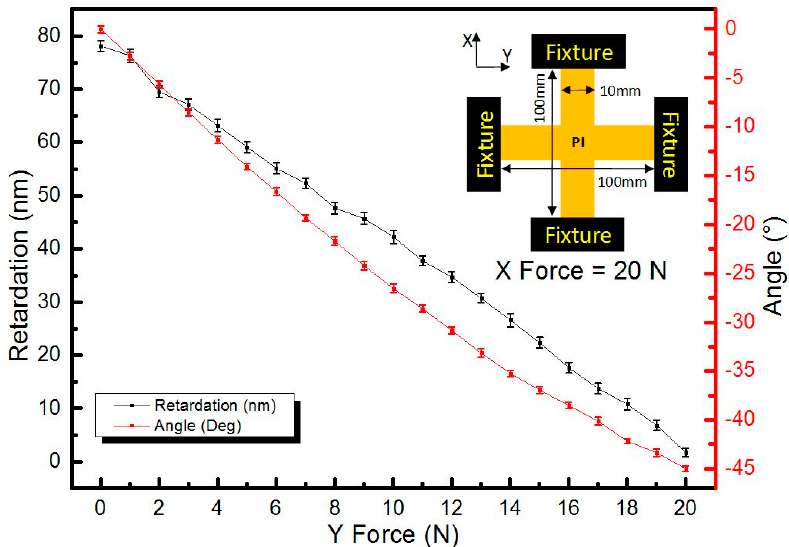
Figure 7. Stress birefringence of PI membrane in biaxial tension mode with a constant 20 N stretching force in X-direction and an increasing stretching force in Y-direction. The black line stands for the retardation value against the Y-direction stretching force and the red line represents the retardation angle against the Y-direction stretching force.